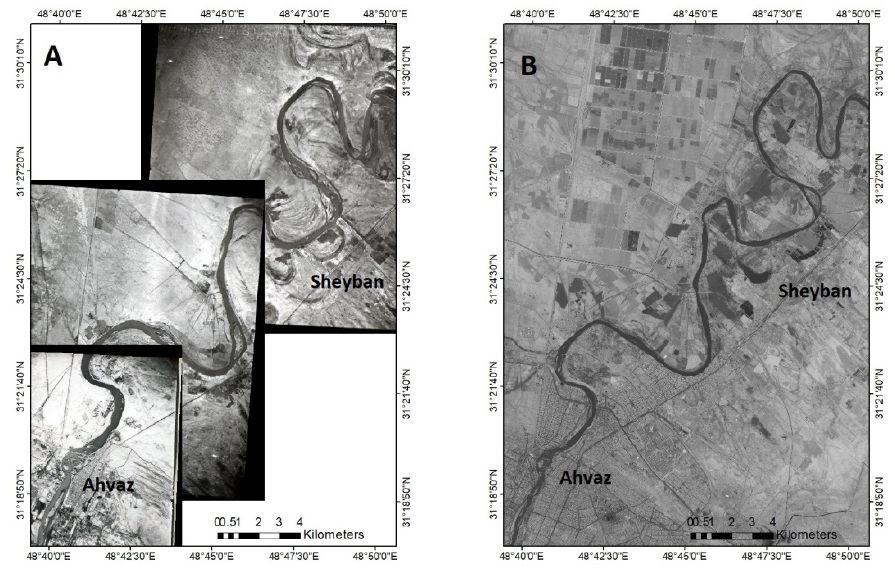
Figure 3. Channel narrowing in the Karun River due to human intervention, especially dam construction [66]: ( A ) aerial photograph of 1954; ( B ) IRS imagery of 2006.